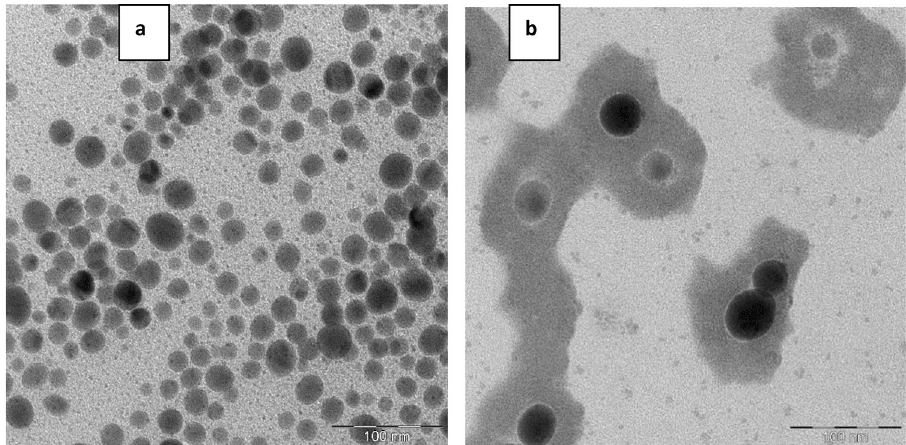
Figure 1. Transmission electron microscopy of Se NPs samples at magnification × 640000: ( a ) the negative sol, ( b ) the positive sol.